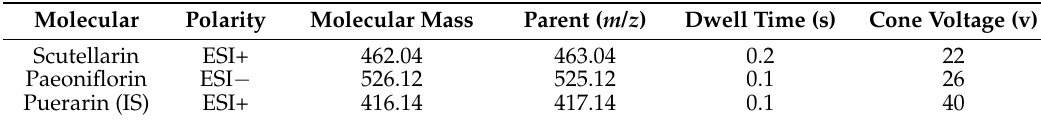
Table 5. Specific mass spectrometric parameters of selected ion recording (SIR) mode of the analytes and puerarin